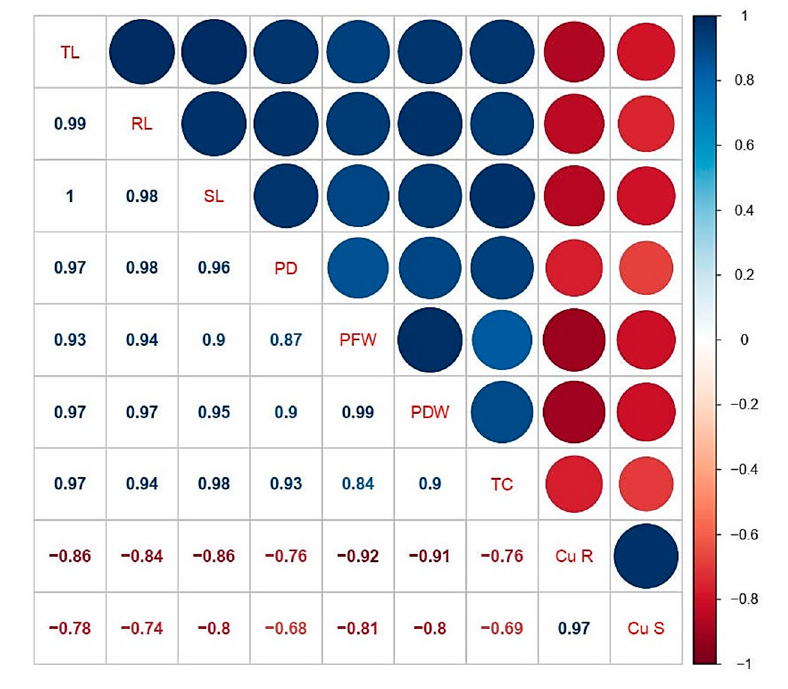
Figure 5. Relationship (r values) between different studies parameters of C. capsularis seedlings grown under different stress levels of Cu with and without CA application. The abbreviations are as follows: TL: total plant length; RL: root length; SL: shoot length; PD: total plant diameter; PFW: plant